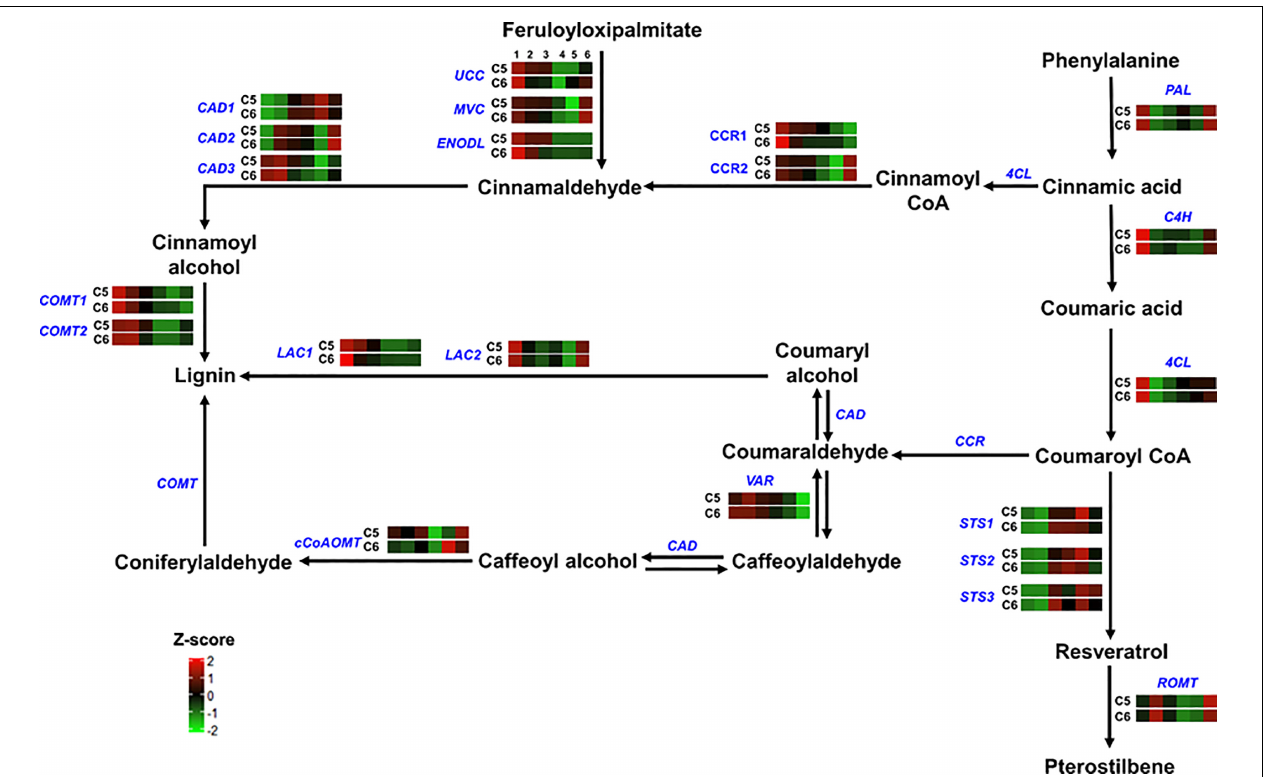
FIGURE 6 | Lignin and pterostilbene pathway. The colored boxes show the accumulation pattern of genes involved in lignin and pterostilbene pathway that were assessed by qPCR at different berry developmental stages, including fruit-set (1), prevéraison (2), véraison (3), postvéraison (4), ripe-skin/flesh (5), and ripe-seeds (6). Red boxes indicate higher levels of expression, and green boxes indicate lower expression levels. The color brightness is directly proportional to the expression ratio, according to the color scale. UCC , uclacyanin-3; MVC , mavicyanin; ENODL , early nodulin; CAD , cinnamyl alcohol dehydrogenase; CCR , cinnamoyl-CoA reductase; VR , vestitone reductase; LAC , laccase; STS , stilbene synthase; ROMT , trans-resveratrol di-O-methyltransferase. Underlined genes, including PAL , C4H , 4CL , and CCoAOMT are shown in Figure 5